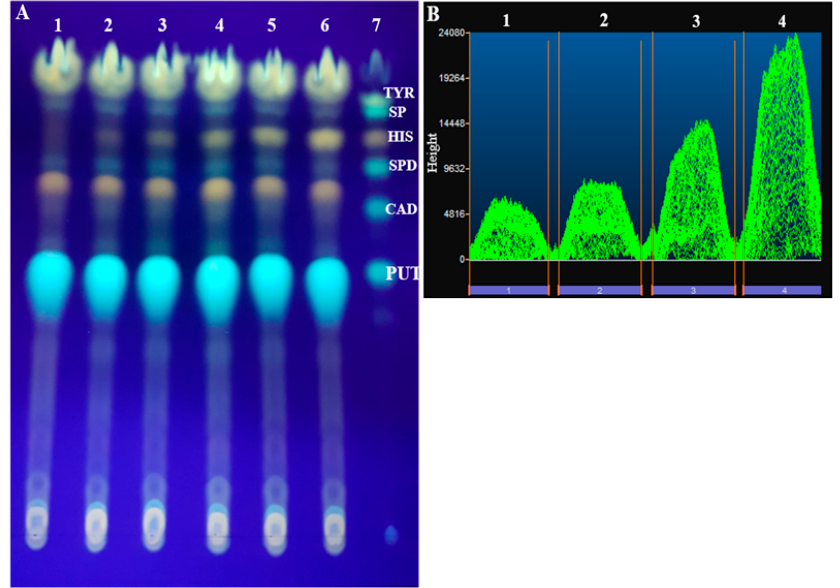
Figure 1. ( A ) Thin-layer chromatographic (TLC) plate of spiked canned tuna visualized under UV lamp at 365 nm: 1 = blank; 2 = 6.25 mg/kg; 3 = 12.5 mg/kg; 4 = 25 mg/kg; 5 = 50 mg/kg; 6 = 100 mg/kg; 7